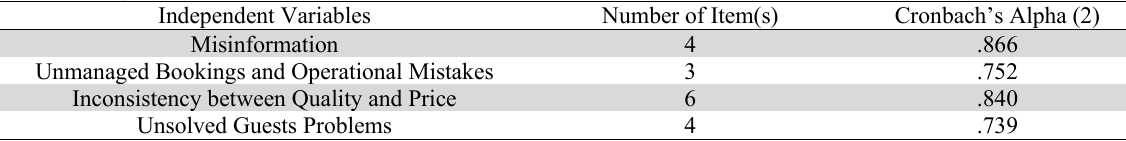
Cronbach’s Alpha for Perceived Stakeholder Conflict Factors – Survey Independent